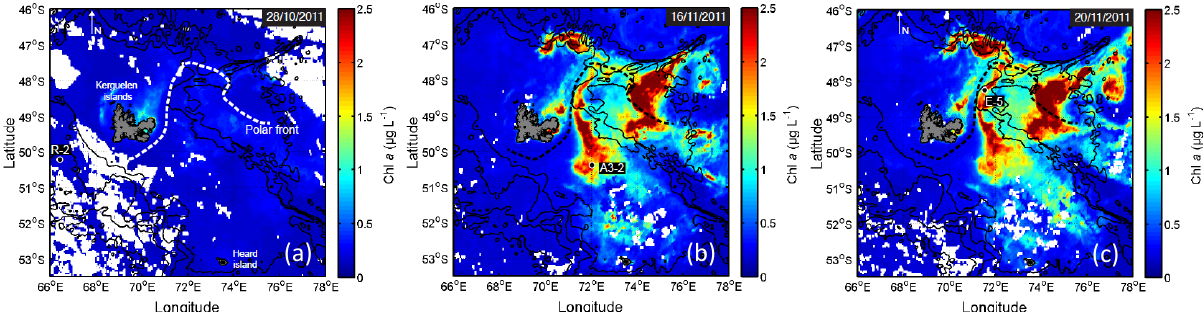
Figure 2. MODIS ocean-colour satellite images showing the development of the plateau and plume blooms during KEOPS-2. Surface chlorophyll (µgL − 1 ) biomass is shown for the nearest clear sky day to the final sampling day at stations R-2 (a) , A3-2 (b) and E-5 (c) . The PF is shown as a black dashed line in (b) and (c) . Trull et al. (2015) discuss the timing of the stations relative to bloom